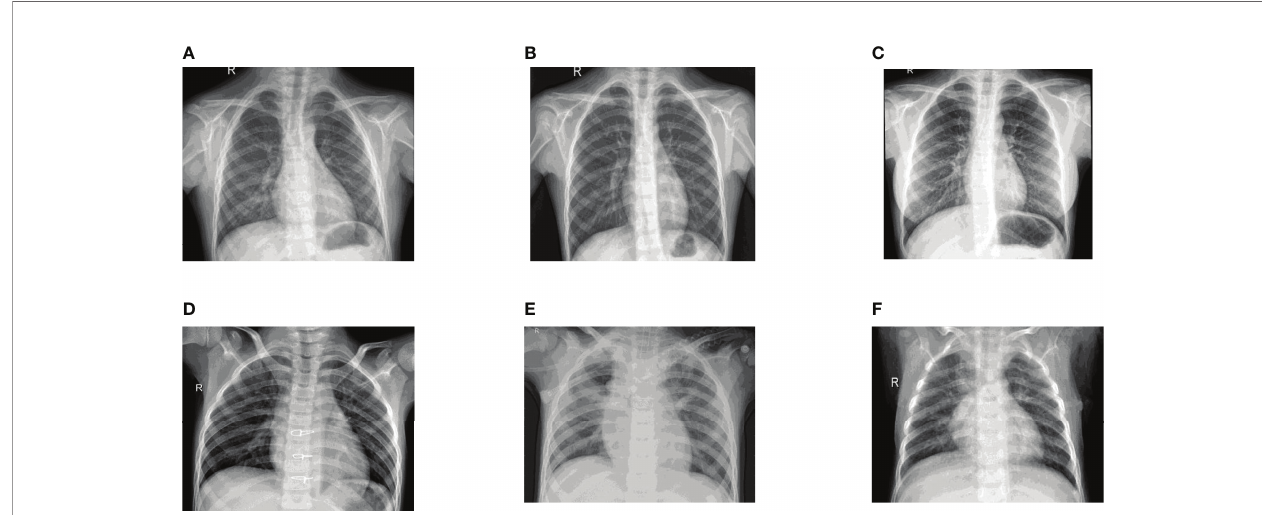
FIGURE 3 | Dataset Images: (A) Healthy Chest X-ray 1, (B) Healthy Chest X-ray 2, (C) Healthy Chest X-ray 3, (D) Pneumonic Chest X-ray 1, (E) Pneumonic Chest X-ray 2 and (F) Pneumonic Chest X-ray 3.